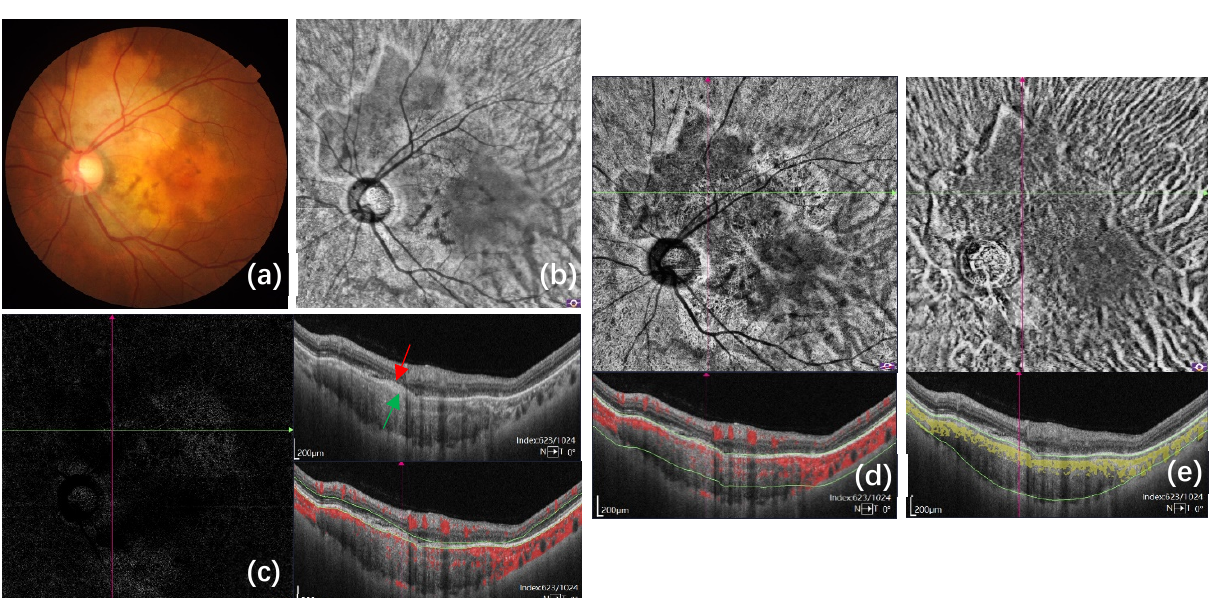
Figure 5. Multimodal imaging of patient 18 (see Table 1): ( a ) fundus photography shows a circumpapillary CO with macular involvement; ( b ) an en face image corresponding to ( e ); ( c ) the avascular layer and corresponding B-scan of SS-OCTA show hyperreflective tumor-like tissue (red arrow) above the disrupted Bruch’s membrane (green arrow) that shows blood flow without subretinal hemorrhage or fluid, which is not indicative of CNV but may be a precursor to active neovasculature; ( d ) the choriocapillaris layer of SS-OCTA shows the blood flow signal of the osteoma is located mainly within the choriocapillaris and partly the Sattler’s layer on the composite B-scan; ( e ) SS-OCTA segmentation covering the entire border of the osteoma on the aligned B-scan images shows the boundary of the tumor clearly demarcated from the adjacent vessels of the choroidal Sattler’s layer and Haller’s layer.